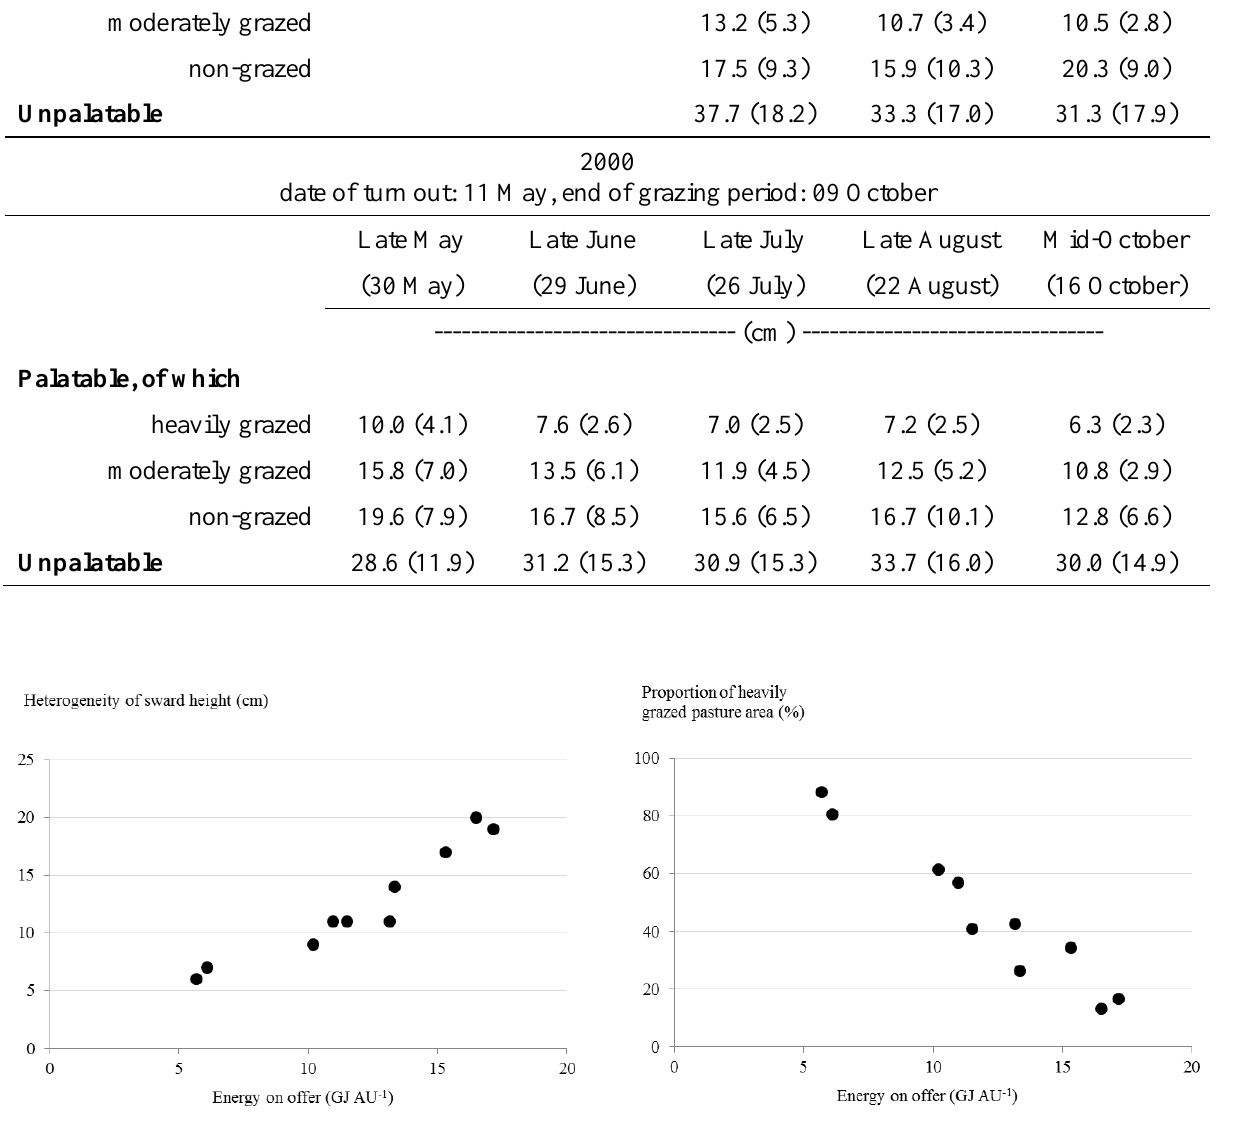
- Q ) (left) and proportion of heavily grazed 90 10